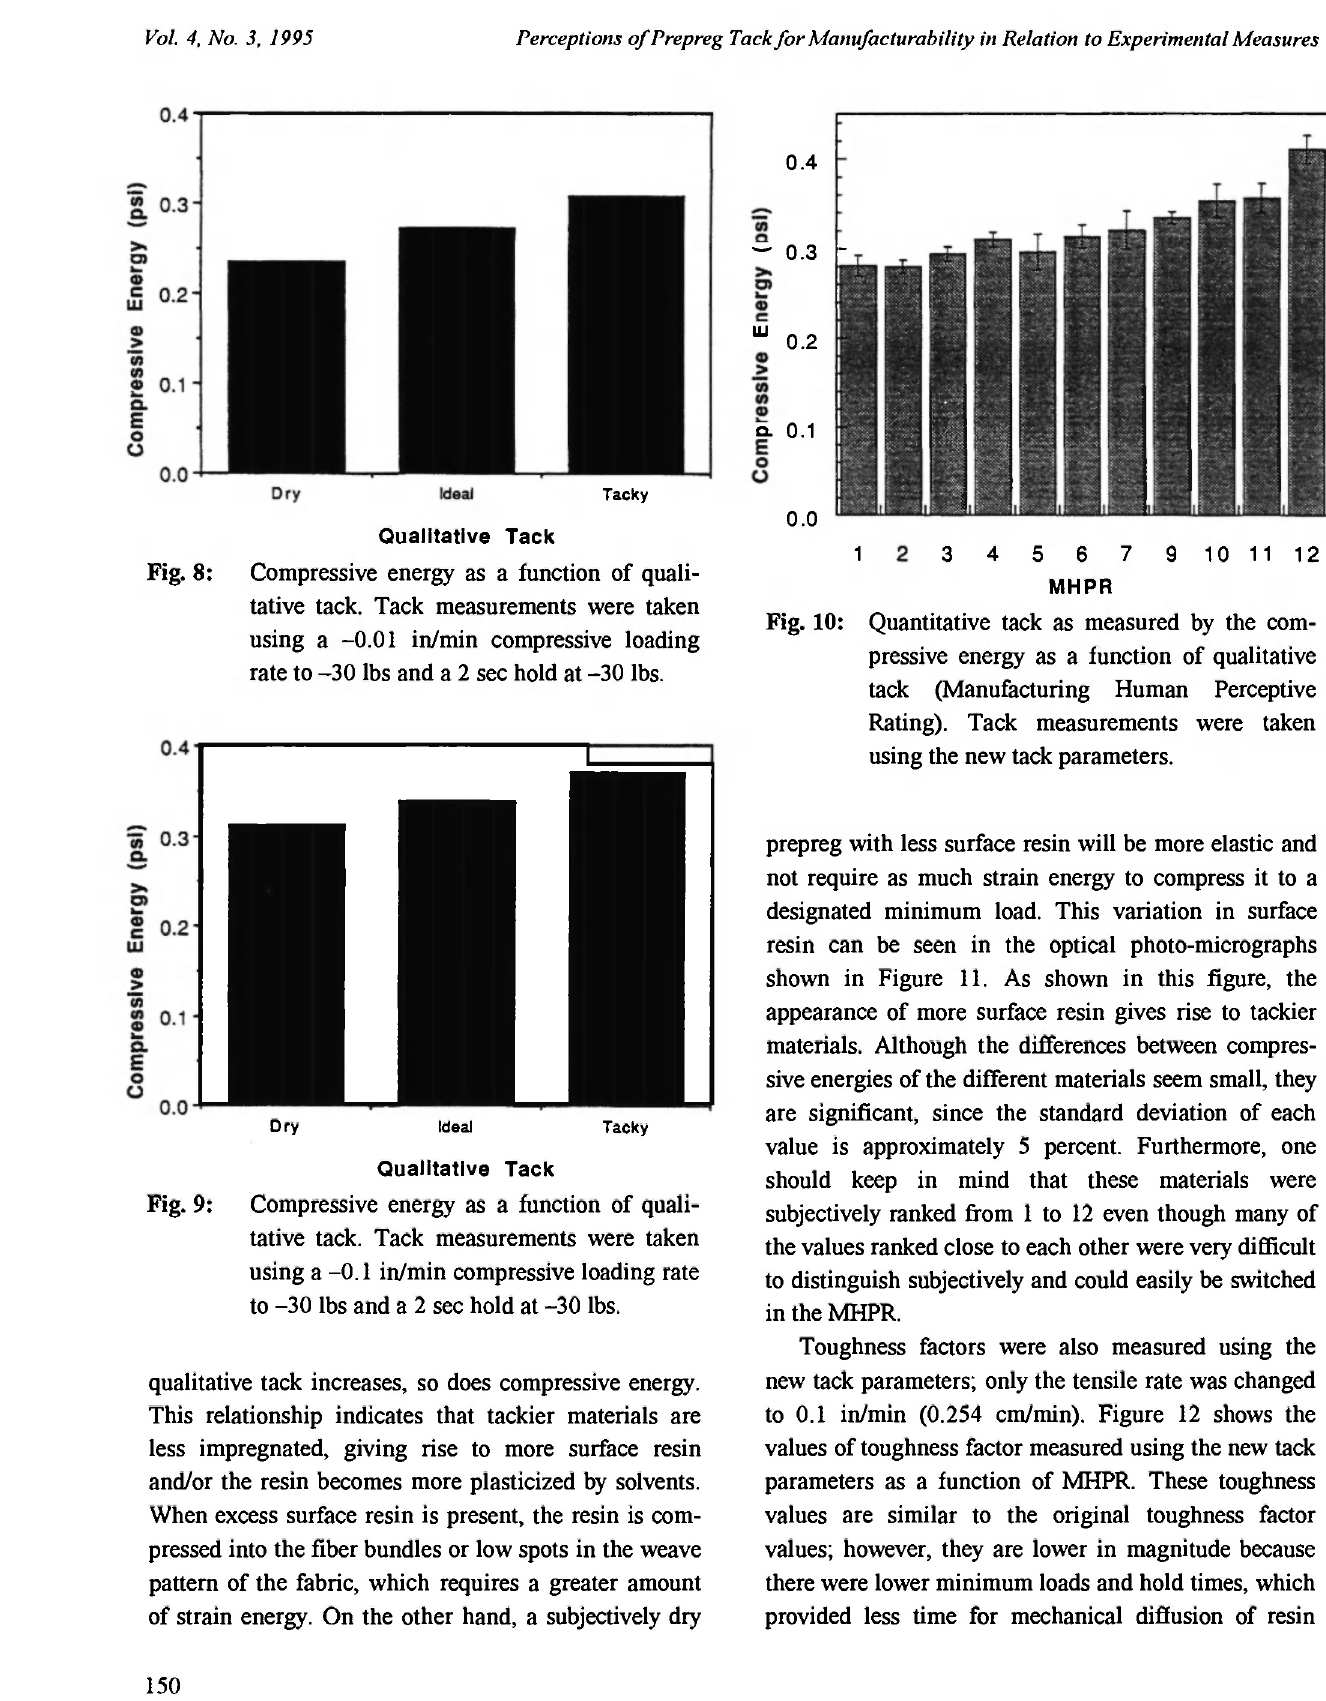
Tacky Qualitative Tack Fig. 8: Compressive energy as a function of quali- tative tack. Tack measurements were taken Fig. 10: Quantitative tack as measured by the com- using a -0.01 in/min compressive loading pressive energy as a function of qualitative rate to -30 lbs and a 2 sec hold at -30 lbs. tack (Manufacturing Human Perceptive Rating). Tack measurements were taken using the new tack